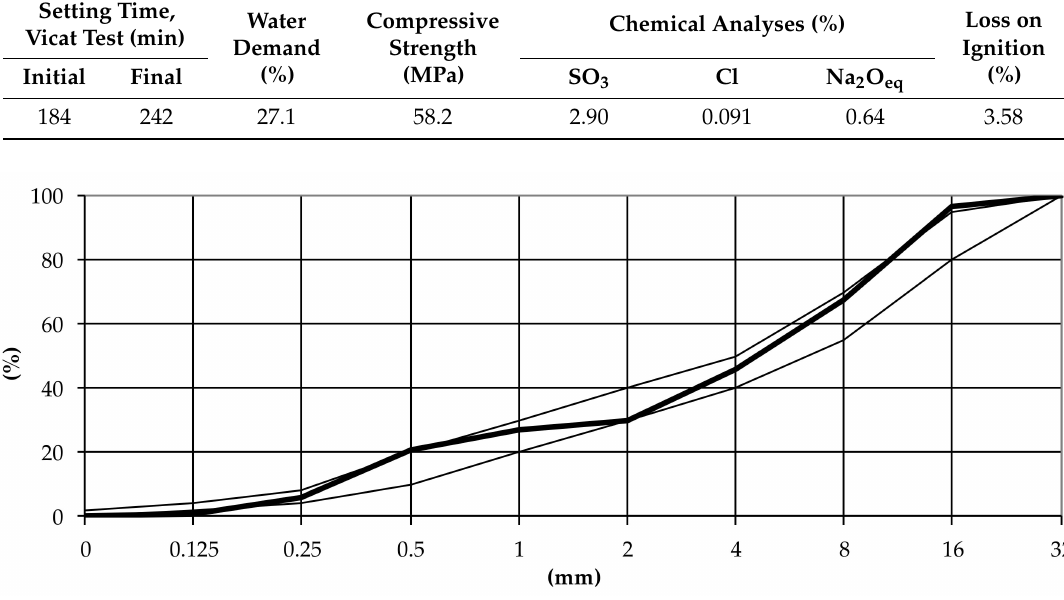
Figure 1. The grain size distribution of the